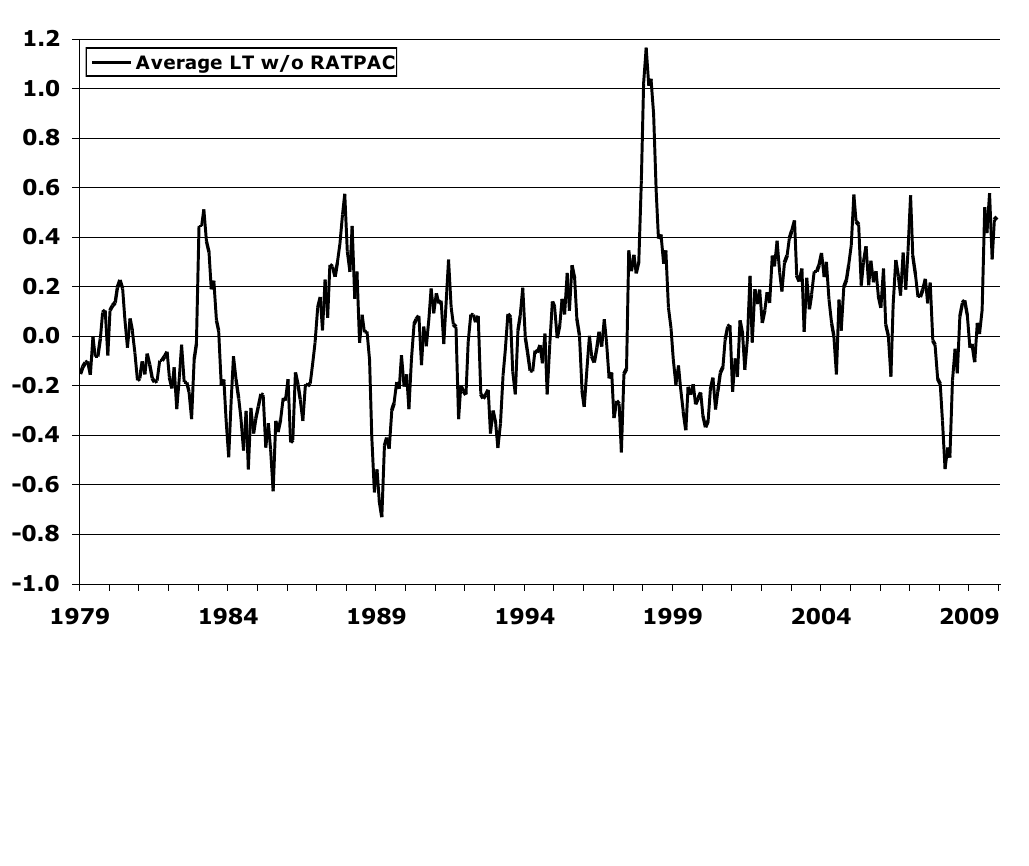
based on UAH, RSS, HadAT, LT